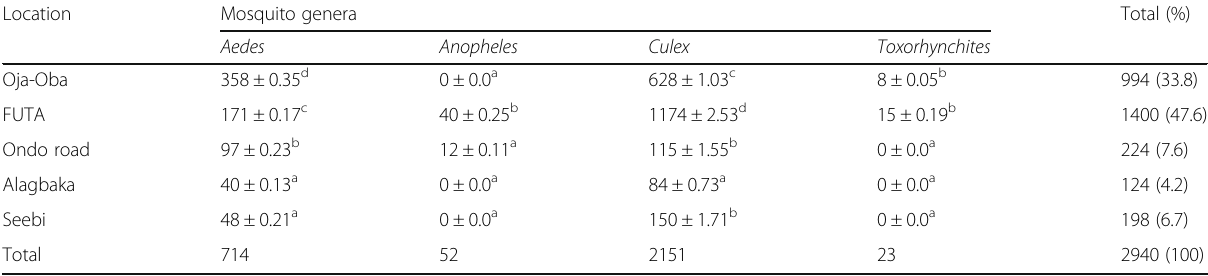
Table 3 Distribution of mosquito genera across sampled locations in Akure South Local Government Area, Nigeria Location Mosquito